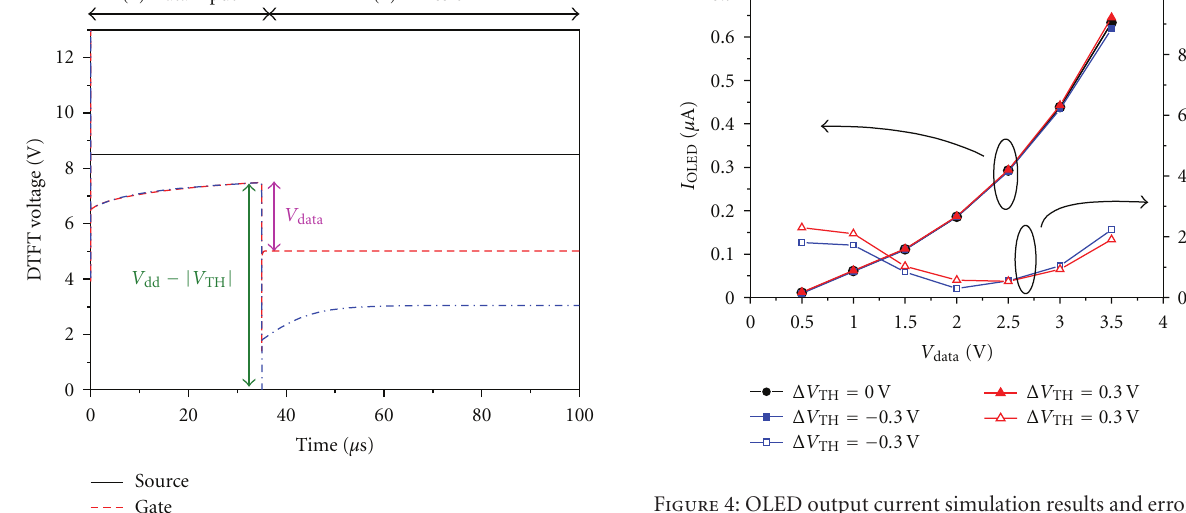
Figure 4: OLED output current simulation results and error rate at di ff erent V data and threshold voltage